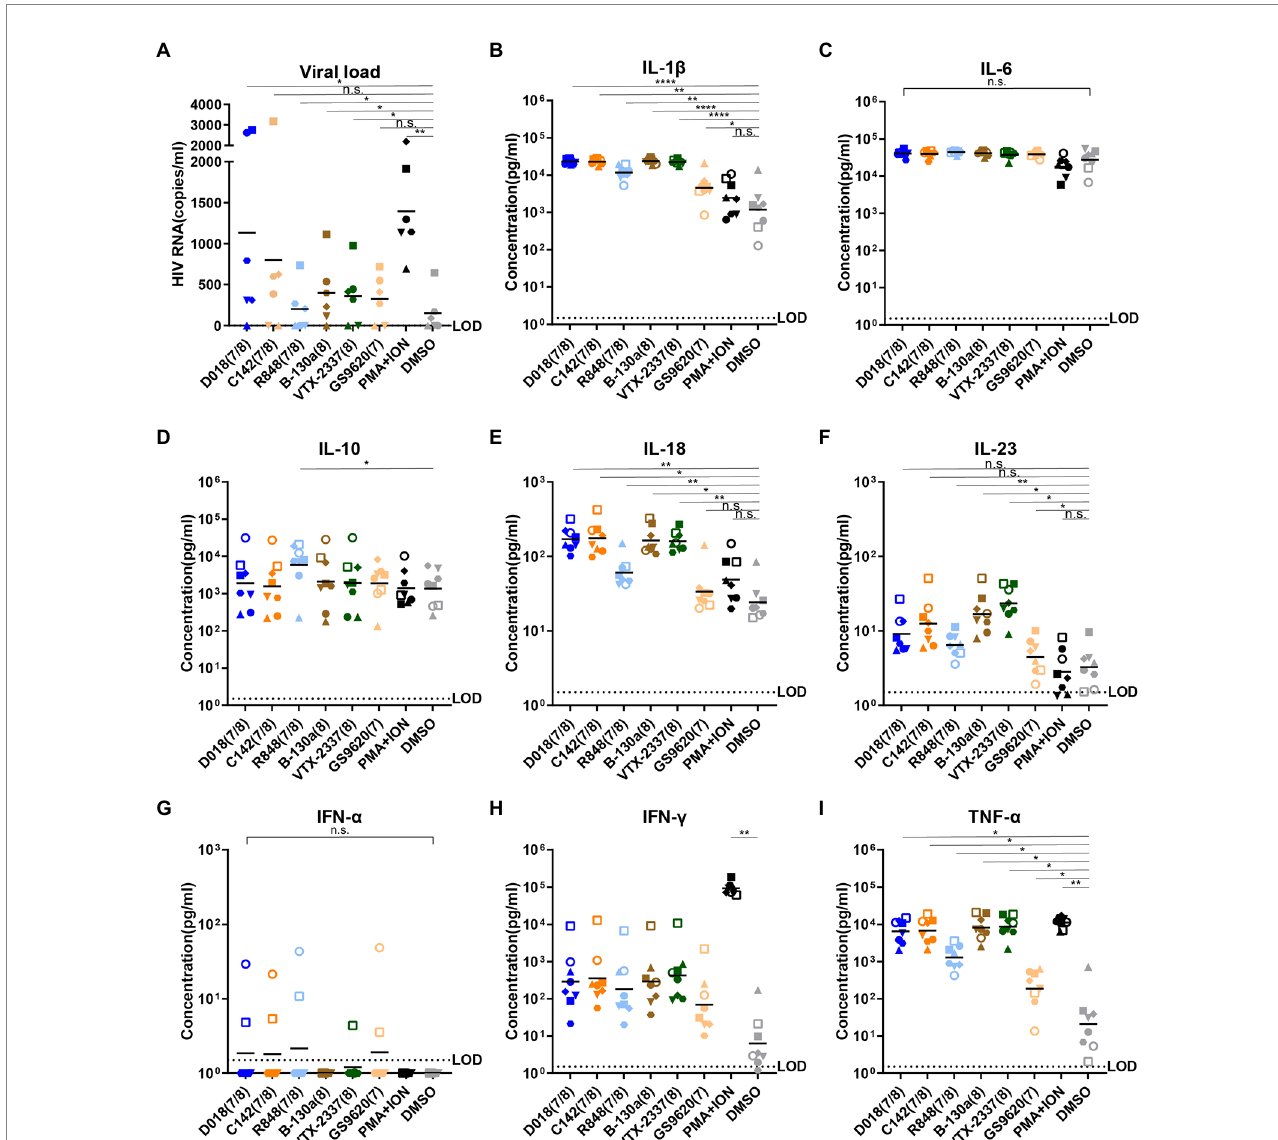
FIGURE 2 TLR7/8 agonists activate latent HIV-1 and inflammatory cytokines from PBMCs of infected individuals. (A) HIV-1 RNA copies in the supernatant were measured by RT-qPCR 4 days after stimulation ( n = 6). (B–I) Concentrations of inflammatory cytokines in the culture supernatant 2 days after stimulation by TLR7/8 agonists, including IL-1 β (B) , IL-6 (C) , IL-10 (D) , IL-18 (E) , IL-23 (F) , IFN- α (G) , IFN- γ (H) , and TNF- α (I) . DMSO was negative control whereas PMA plus Ionomycin were positive control. PBMC from each HIV-1 infected patient ( n = 6) with different shape was filled and PBMC from each normal control ( n = 2) with different shape was an open symbol. Data are shown as the mean of two replicates for each donor. Statistical difference between various TLR7/8 agonists and DMSO group analyzed by paired- t -test. **** p < 0.0001, *** p < 0.001, ** p < 0.01, * p < 0.05, n.s. not